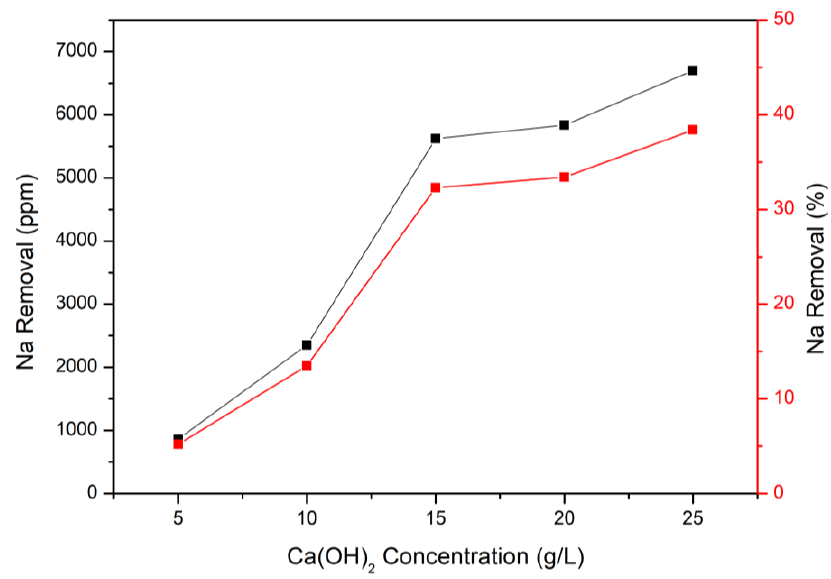
Figure 8. Removal of sodium at different Ca(OH) 2 concentrations through modified Solvay pro-